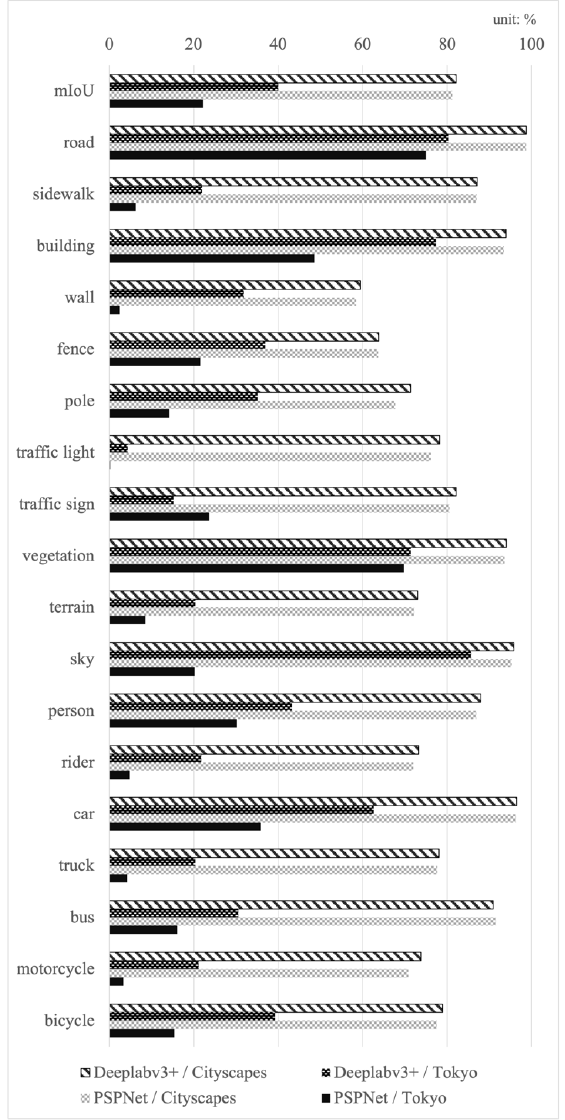
Figure 1 . The mIoU and by-class IoUs for Germany and Japan. The mean IoU was 82.1% using DeepLab v3 plus and 81.2% using PSPNet on the Cityscapes dataset (Cityscapes Dataset, 2022). However, the accuracy dropped to 40.0% and 22.2%, respectively, for the Tokyo dataset. The range of accuracy decreases were relatively small for the "road" (18.4 points for DeepLab v3 plus and 23.8 points for PNPNet) and "vegetation" classes (22.6 points and 23.9 points, respectively). On the other hand, it was the most significant for the "sidewalk" class, at 65.0 and 80.6 points, respectively. This was followed by the "traffic light" class results, at 73.7 and 76.9 points, respectively.